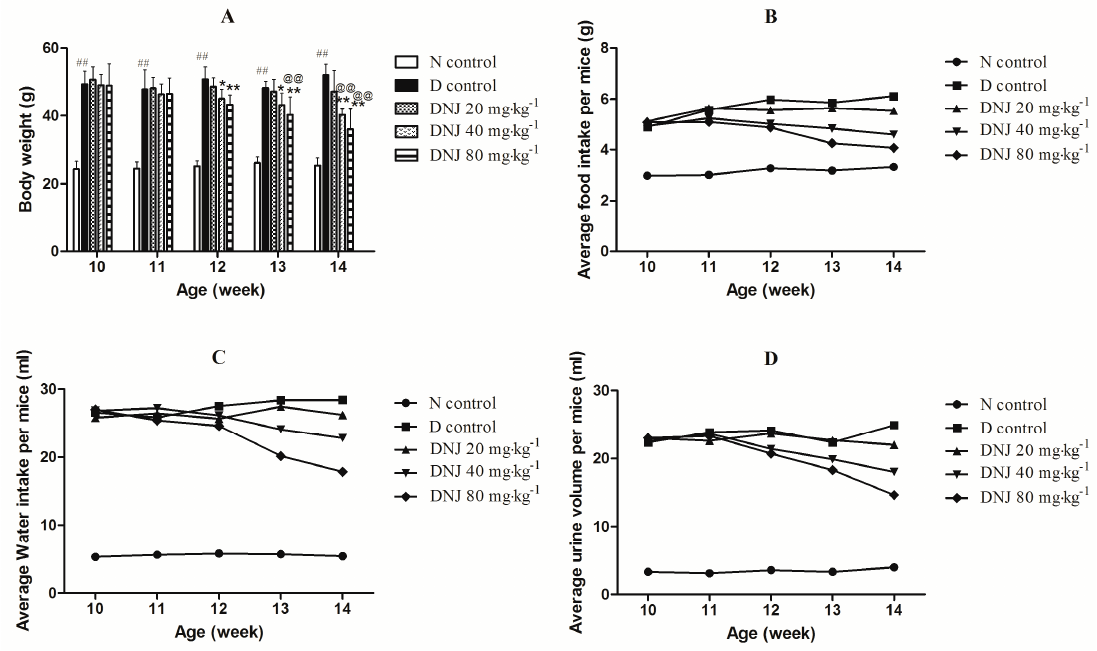
Figure 3. Effects of DNJ on body weight ( A ); and average food intake ( B ); water intake ( C ); and urine output ( D ) of db/db mice. Normal saline or DNJ were administered intravenously to N control mice or db/db mice for four weeks. ## p < 0.01 vs. N control; * p < 0.05, ** p < 0.01 vs. D control; @@ p < 0.01 vs. DNJ 20 mg·kg − 1 ·day − 1 ( n = 6).